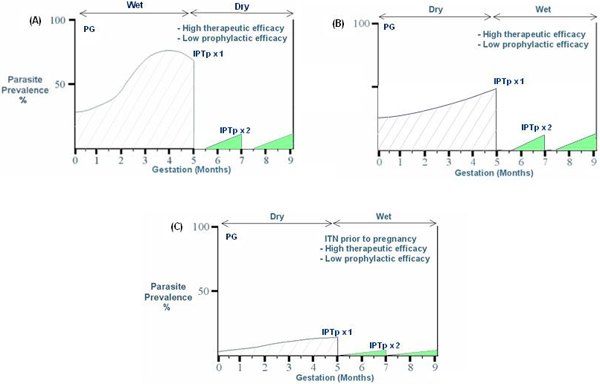
Influence of seasonal effects and ITN use prior to pregnancy on parasite burden in primigravidae (PG). (A) First trimester occurring during the wet season and two dose SP-ITPp prescribed in dry season; (B) First trimester in the dry season and two dose SP-ITPp prescribed in wet season; (C) Good ITN adherence prior to and during first trimester in dry season with subsequent two dose SP-ITPp in wet season. The Entomological Inoculation Rate (EIR) is assumed to be approximately 20/month in the wet season and <5/month in the dry season.